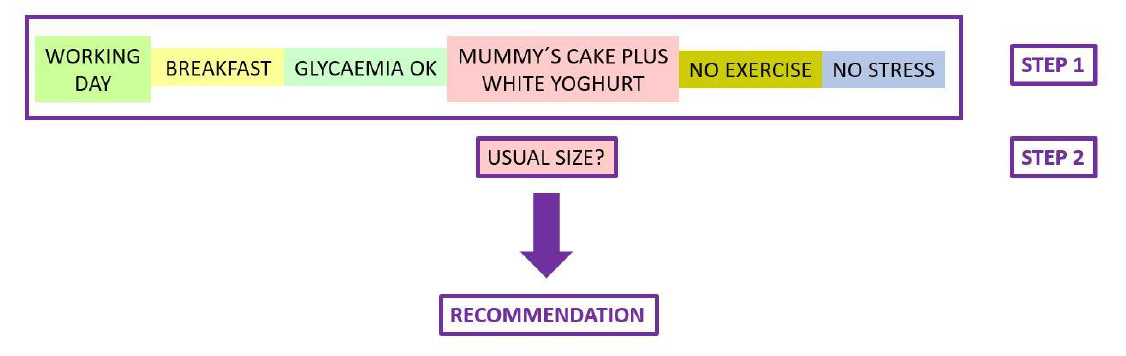
Figure 2. Event categorization. App—application.